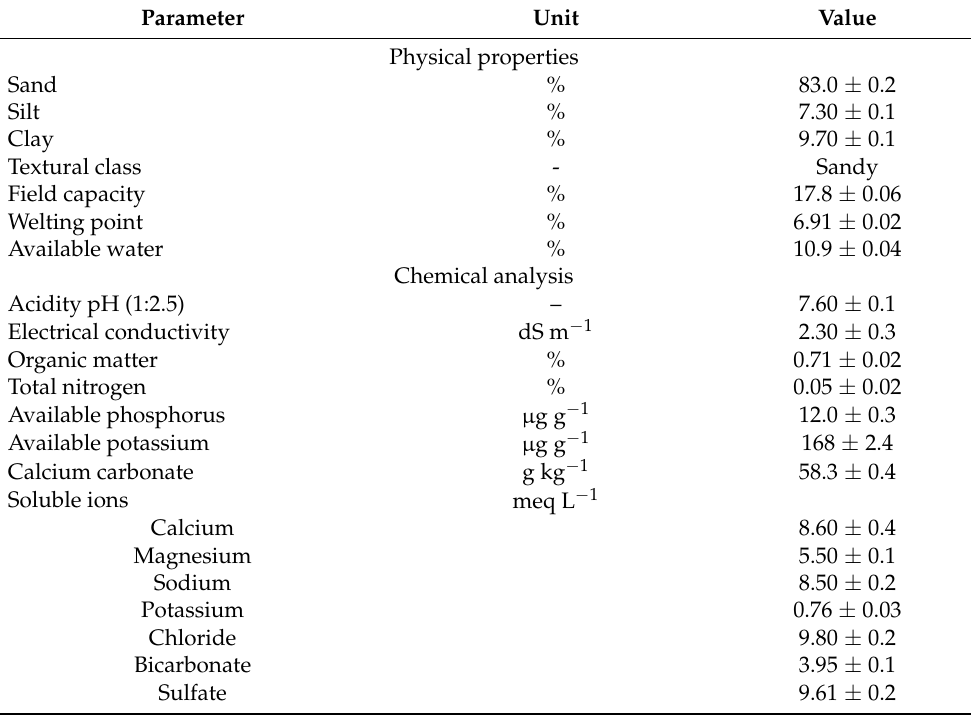
Table 1. Properties of the soil (0–30 cm depth) at Imam Malik village, Kom Hamada, El-Bahira governorate,